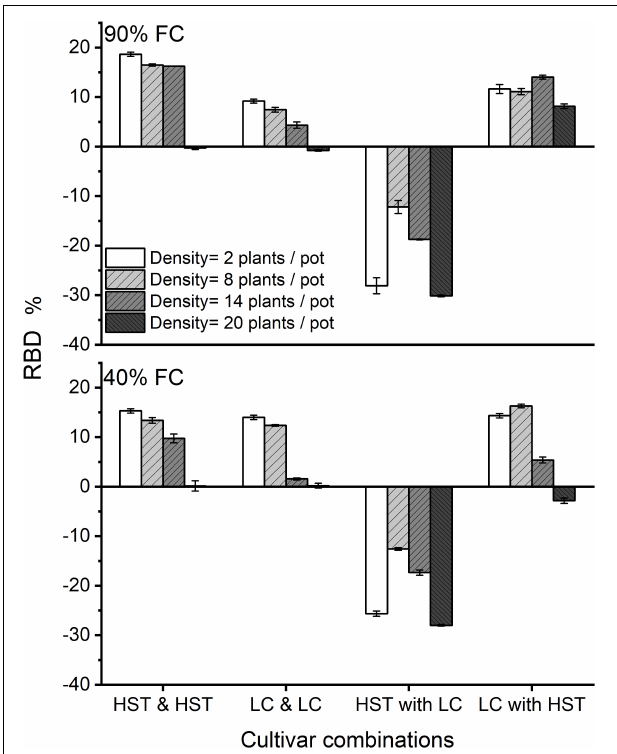
FIGURE 7 | Effects of net vs. film dividers of two cultivars at different densities. RBD is the changes in root biomass due to net vs. film dividers. HST and LC are the cultivars. HST and HST/LC and LC signify the same cultivar on both sides of the dividers. HST with LC and LC with HST refers to different cultivars in a pot. FC is field water capacity. The error bars indicate one standard error of the